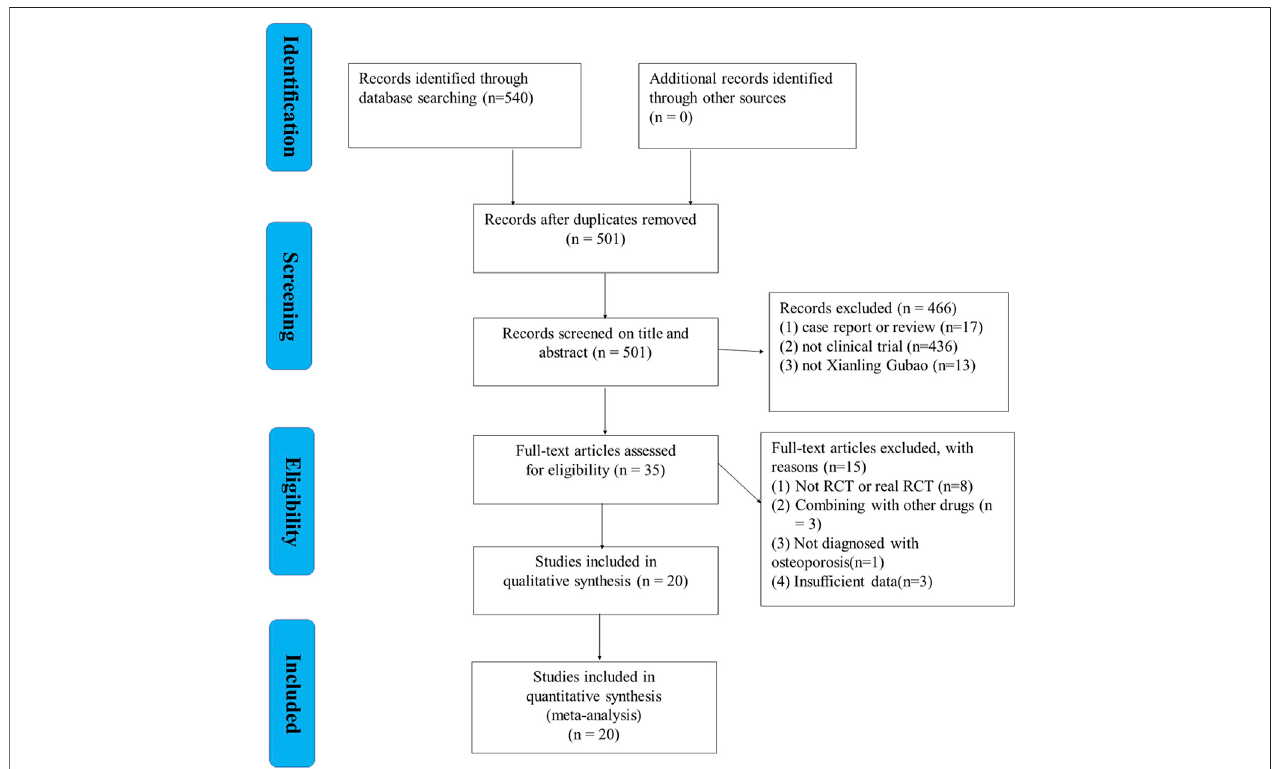
FIGURE 1 | Flowchart of study